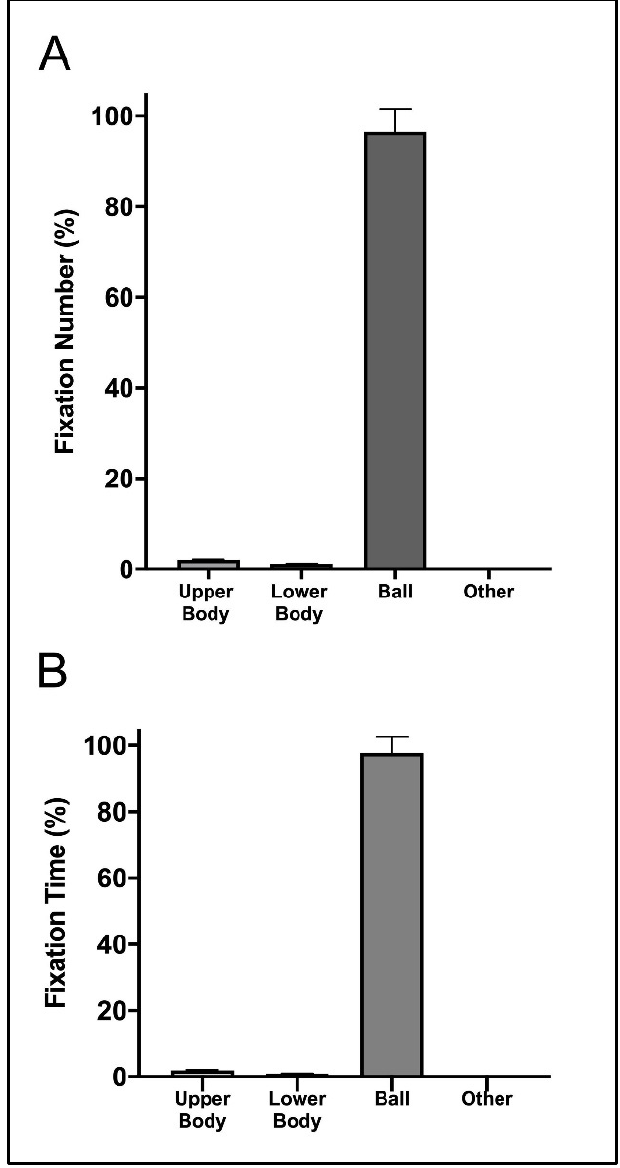
Figure 5. Mean (bar) and standard deviation (error bars with 95% confidence interval) of the relative fixation number ( A ) and fixation time ( B ) for the volley return